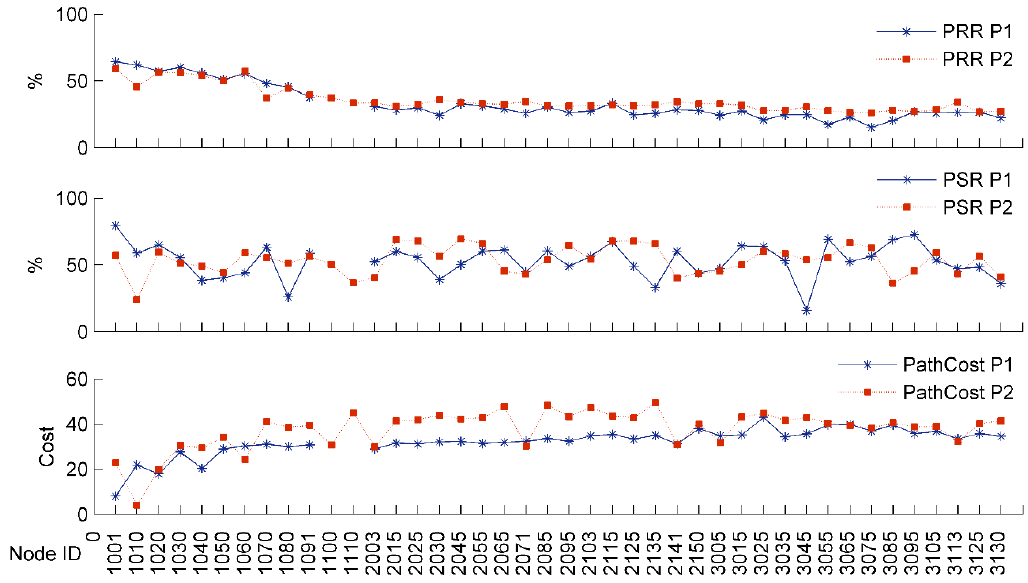
Figure 7. Daily averages of individual node packet reception rate (PRR), packet success rate (PSR), and XMesh path cost during evaluation periods P1 and